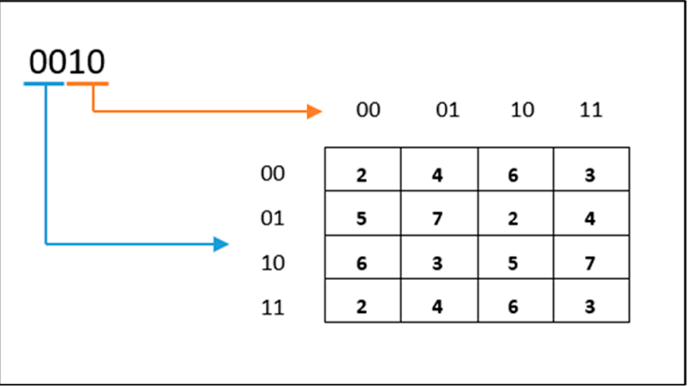
Figure 6. The proposed S ‐ Box.